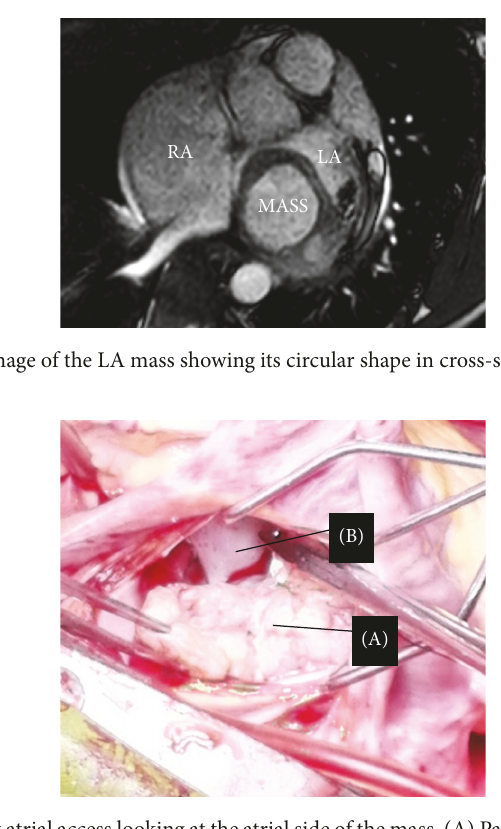
Figure 5: Perioperative image from left atrial access looking at the atrial side of the mass. (A) Parachute-shaped tuberculoma as viewed from above (exposed through LA approach); (B)